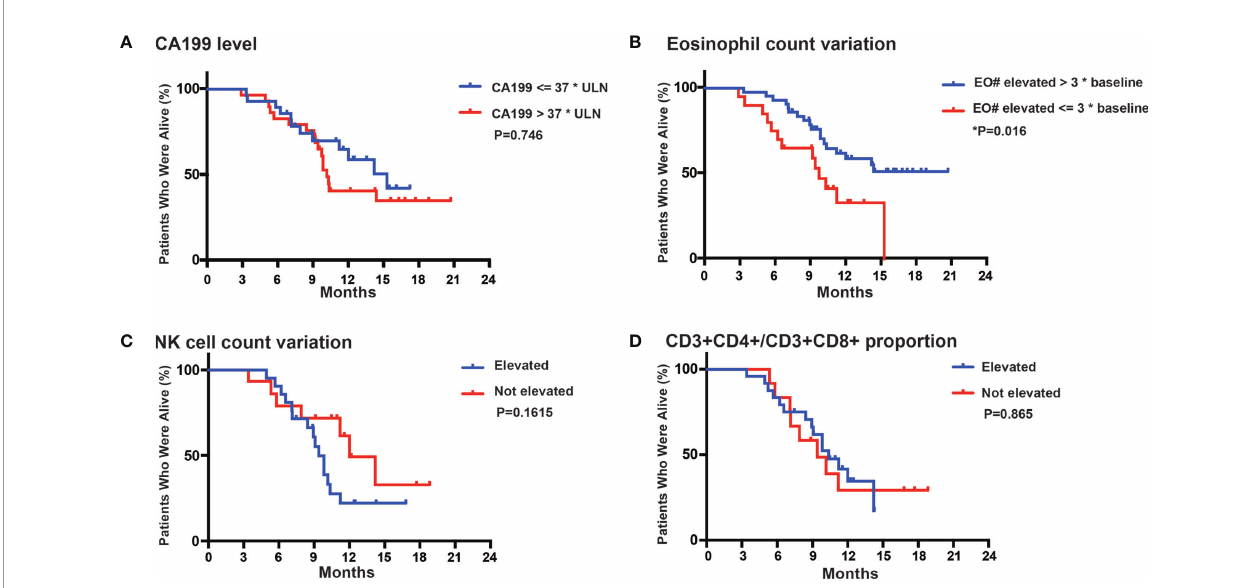
FIGURE 4 | Subgroup analysis in CA199 level (A) , Eosinophil count variation (B) , NK cell count variation (C) and CD3+CD4/CD3+CD8+ proportion (D) . *P <